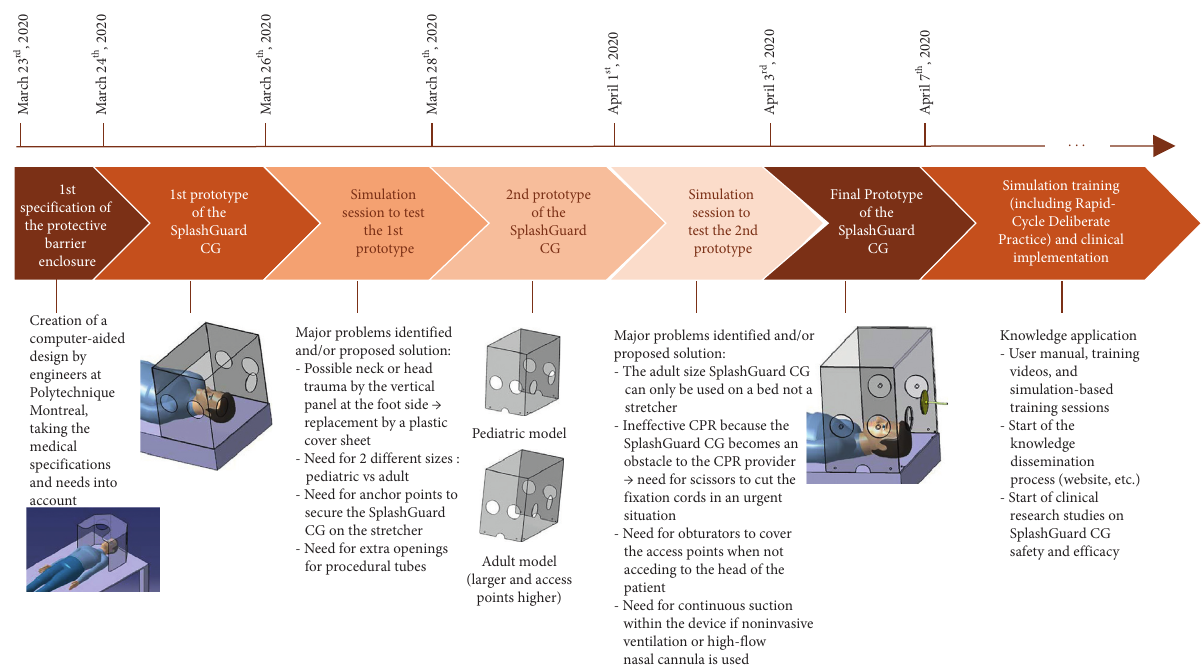
Figure 1: Main steps in the design and implementation of the SplashGuard